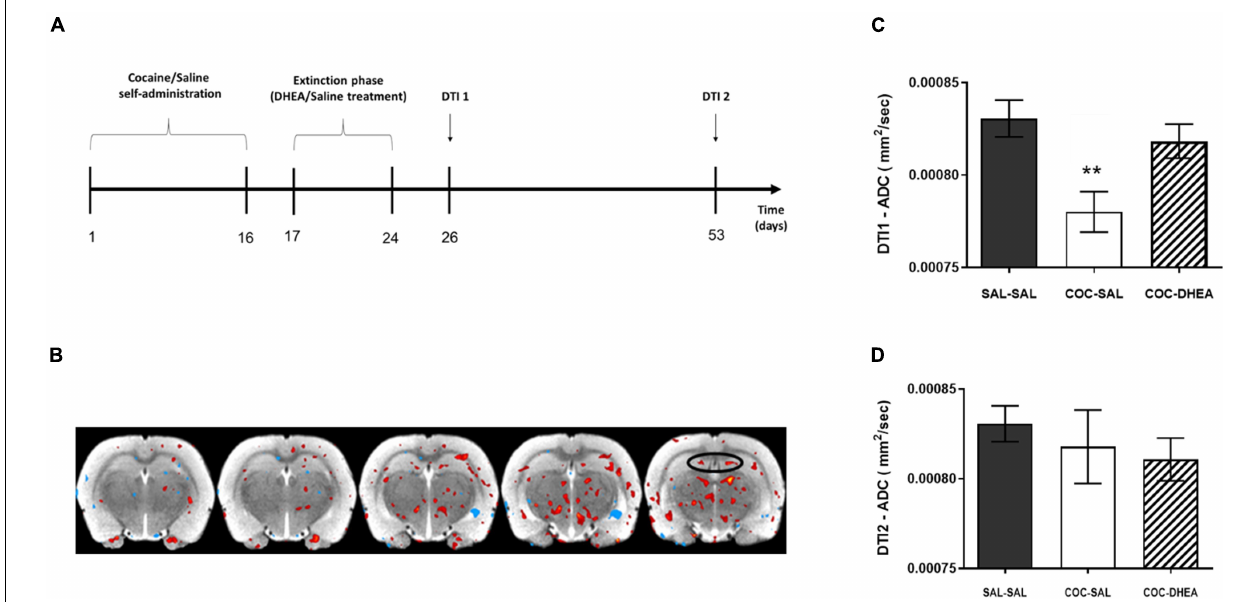
FIGURE 3 | Effect of DHEA treatment on average diffusion in dentate gyrus area after cocaine self-administration. (A) Flow chart of DTI experimental procedures: rats were trained to self-administer cocaine or saline for 16 days. After rats achieved stable maintenance, they were treated with DHEA or saline during 8 days of extinction. 48 h later, a part of the rats was DTI scanned, corresponding to proliferation measurement (DTI1). A second group underwent the DTI scan after 28 days, corresponding to neurogenesis measurement (DTI2). (B) An illustrative image of the comparison between ADC values in COC-SAL vs. SAL-SAL brains. Red stain indicates a decrease in ADC value; blue indicates an increase in ADC value. (C,D) Quantification of the average diffusion in the tissue, ADC parameter, in the DTI1 and DTI2 measurement points. DTI1’s one-way ANOVA [ F (2,24) = 6.849, p < 0.001] revealed a significant effect between COC-SAL and SAL-SAL groups ( n = 8–9, ** p < 0.01, Bonferroni’s multiple comparison test). No significant effect was revealed between the three groups in the DTI2